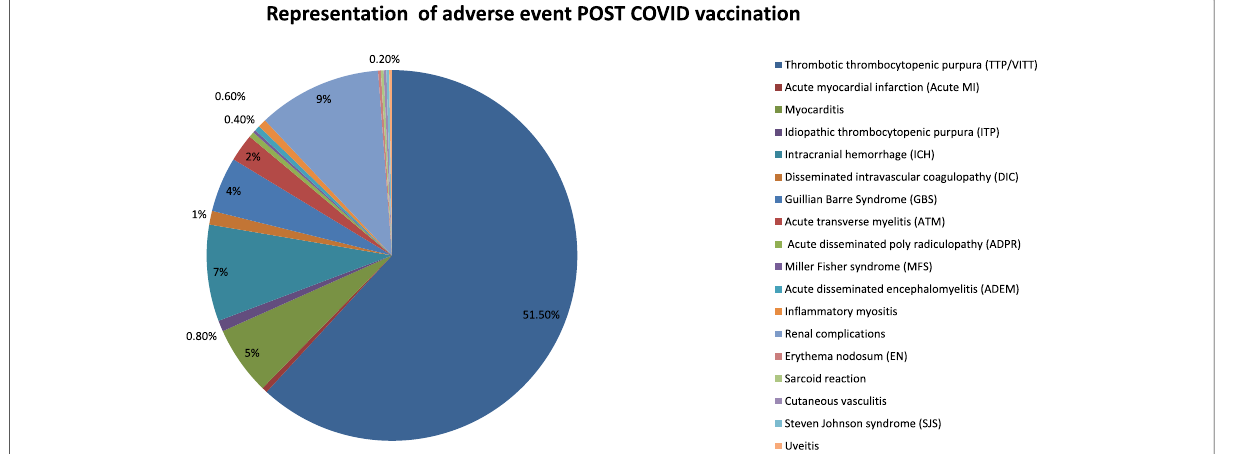
Fig. 2 Different adverse events post-COVID vaccination in the study population in number and